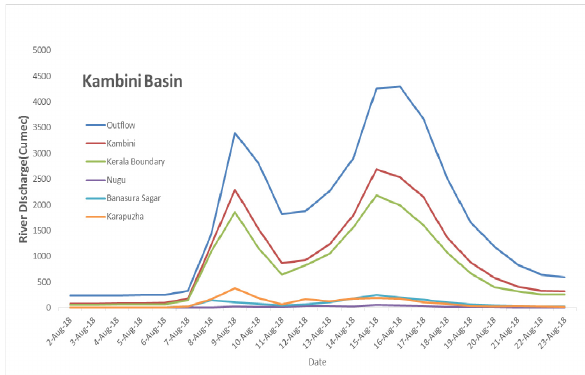
Figure 14c: Daily flow obtained from HEC-HMS for outlets and major dams of Kambini river